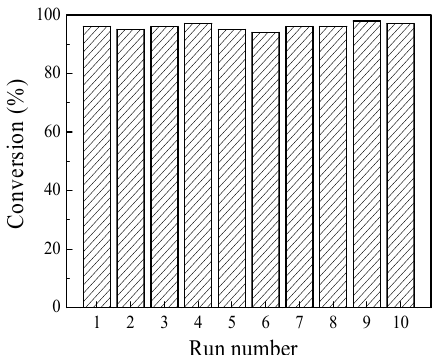
Figure 6. Recycling experiments of catalyst 1 for epoxidation of cis-cyclooctene with air / IBA. Reaction conditions: catalyst 10 mg, cis-cyclooctene 1.0 mmol, CH 3 CN 10 mL, flow of air 10 mL / min, IBA 2.0 mmol, reaction temperature 40 ◦ C, reaction time 3 h. All selectivities for the epoxide are ≥ 99%.